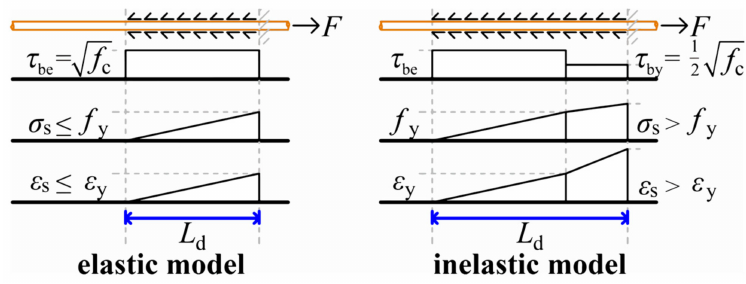
Figure 6. The two-stage bond-slip model, adapted from ref.